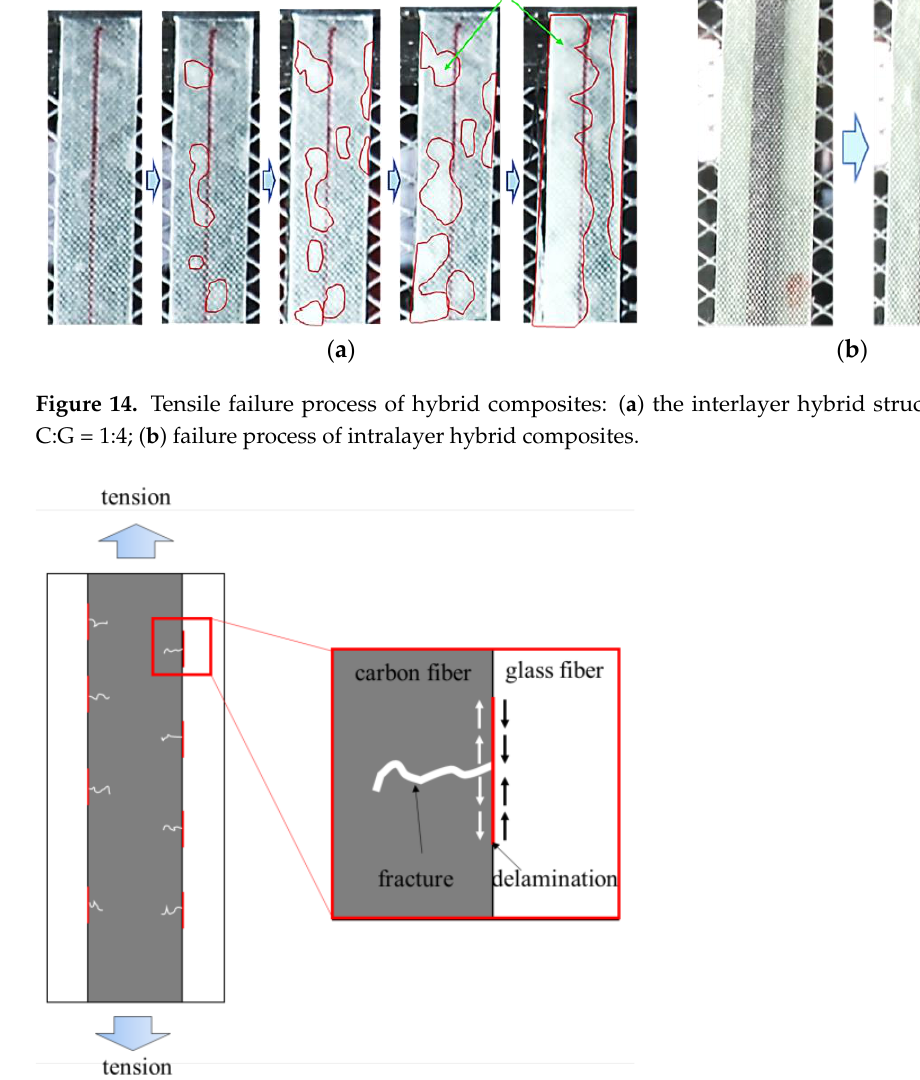
Figure 14. Tensile failure process of hybrid composites: ( a ) the interlayer hybrid structure with C:G = 1:4; ( b ) failure process of intralayer hybrid composites.